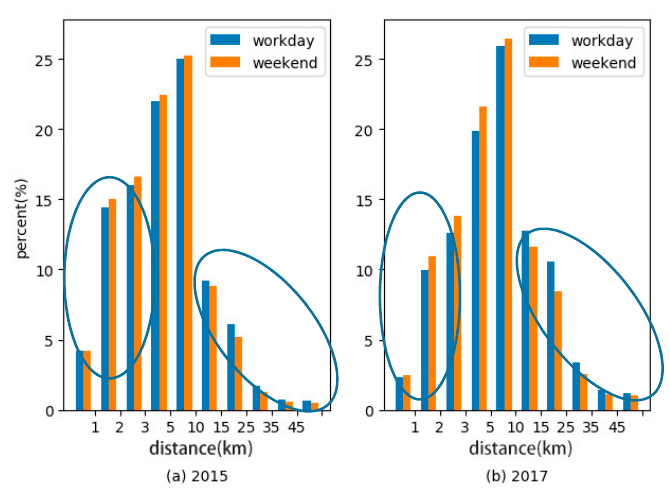
Figure 2. Frequency distribution of the distance of occupied trips in ( a ) 2015 and ( b ) 2017.